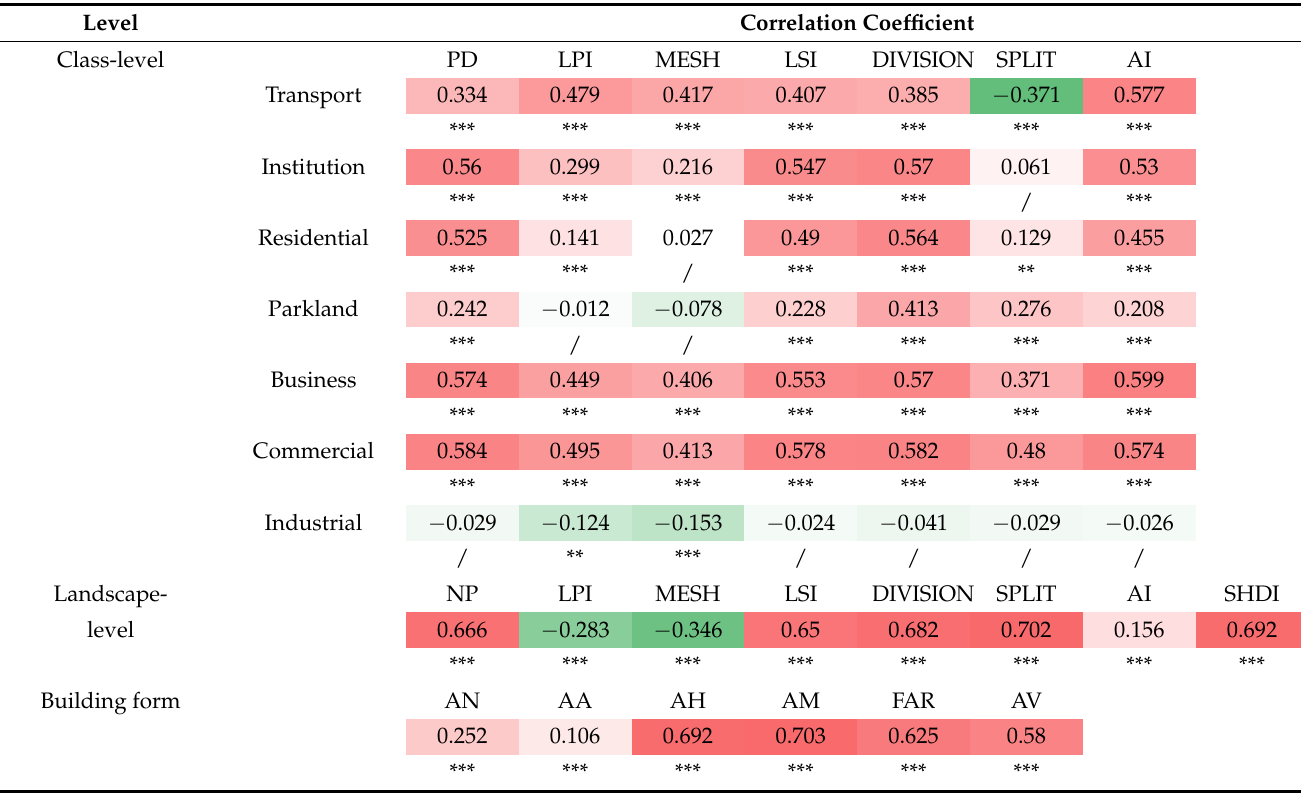
Table 3. Correlation coefficient between USS features and NTLI. Red represents positive correlation; green represents negative correlation; the darker the color, the stronger the